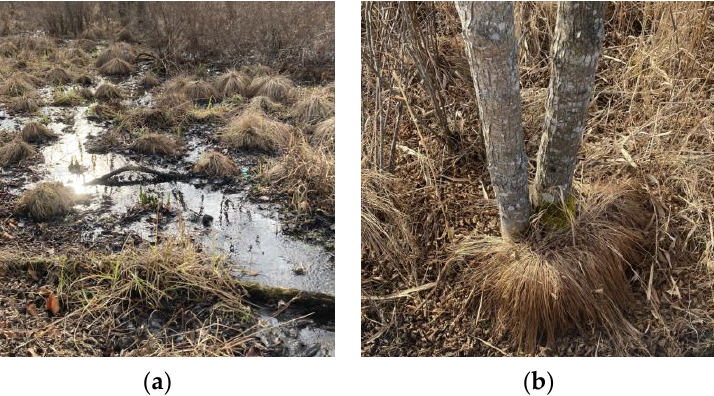
Figure 12. The herbaceous clumps of the sedge family in the Kushiro Wetland ( “Yachibouzu” in Japanese): ( a ) Without alder trees. ( b ) With alder trees. Japanese): ( a ) Without alder trees. ( b ) With alder